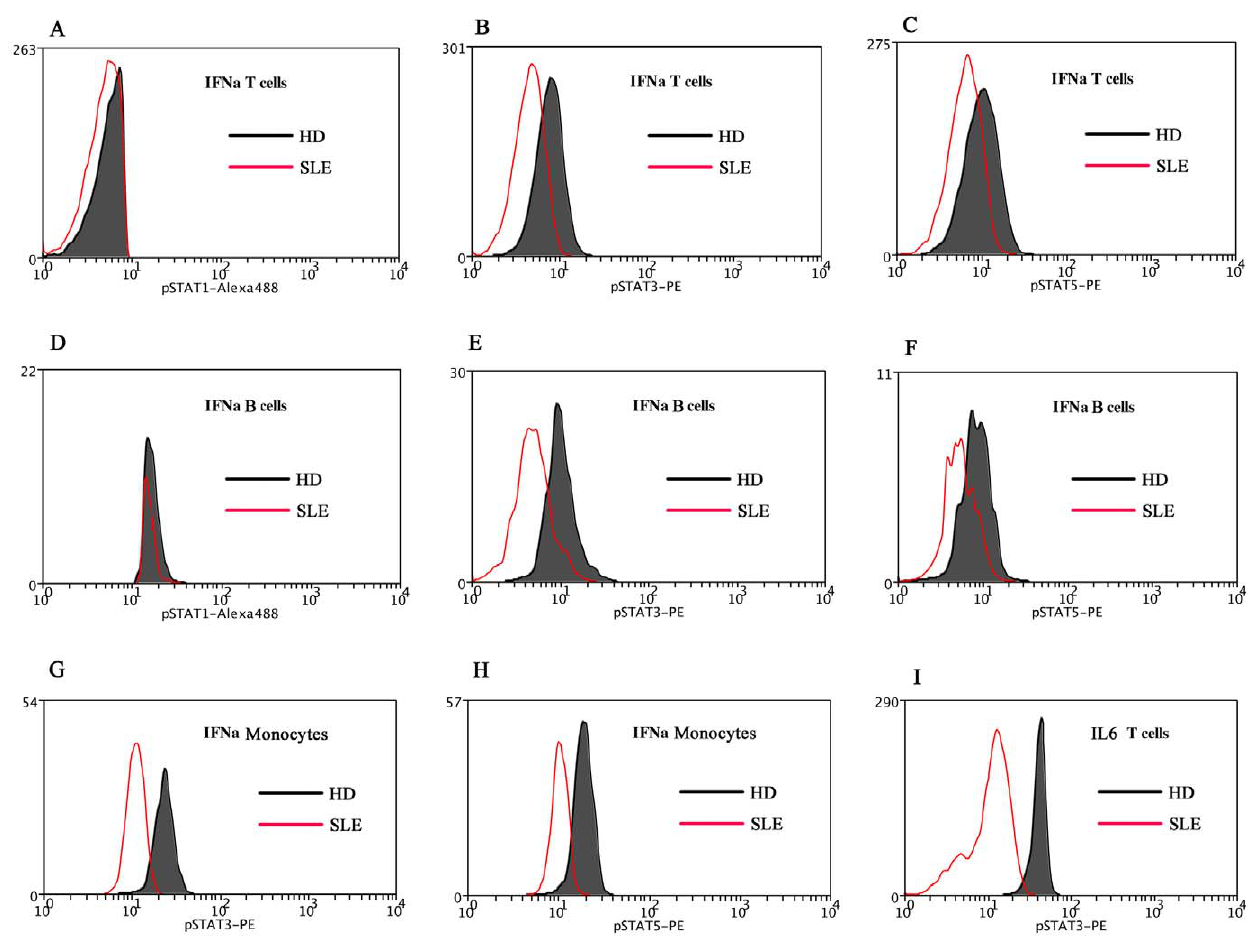
Figure 6. Comparison pSTATs expression between SLE patient and healthy donor (HD) after cytokine stimulation. A representative experiment is shown. The MFI for the phosphorylation of STAT1 (5A), STAT3 (5B), and STAT5 (5C) in the T cells of SLE patient was compared with that of HD. The MFI for the phosphorylation of STAT1 (5D), STAT3 (5E), and STAT5 (5F) in the B cells of SLE patient was compared with that of HD. The MFI for the phosphorylation of STAT3 (5G) and STAT5 (5H) in the monocytes of SLE was compared with that of HD. The MFI for pSTAT3 (5I) in the T cells of SLE patient was compared with that of HD. MFI, mean fluorescence index; SLE, systemic lupus erythematosus; HD, healthy donor; IFN a , interferon a .